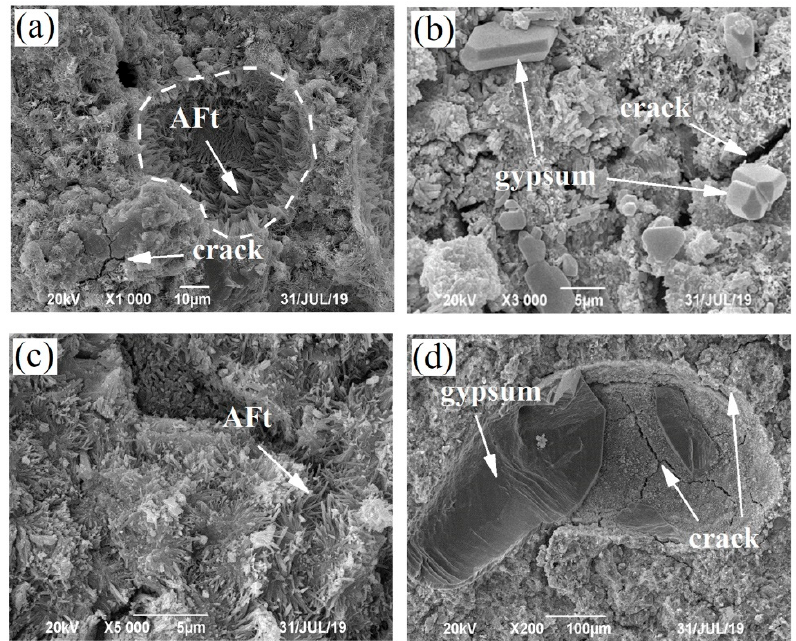
Figure 9. Partially immersed specimens for 80 days, SEM image of ( a ) and ( b ) PC specimen evaporation zone, ( c ) and ( d ) LS30 specimen immersion zone.